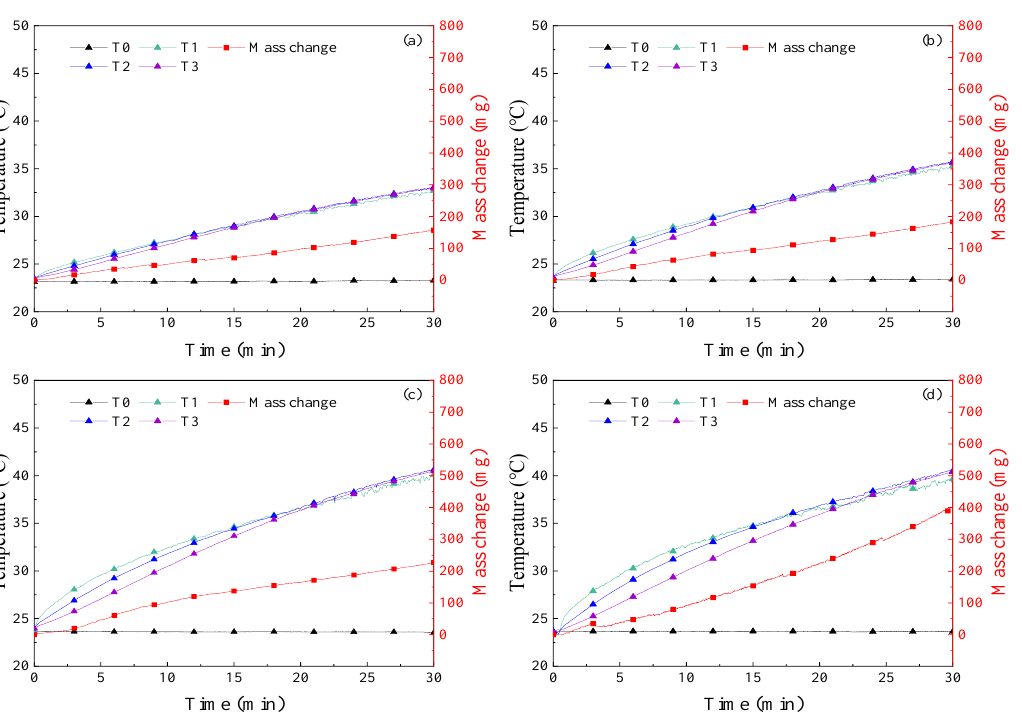
Figure 6. Curves of temperature and mass change of Ag nanofluids in experiments on solar – thermal conversion characteristics ( a ) 50 ppm; ( b ) 200 ppm; ( c ) 500 ppm; ( d ) 1000 ppm.